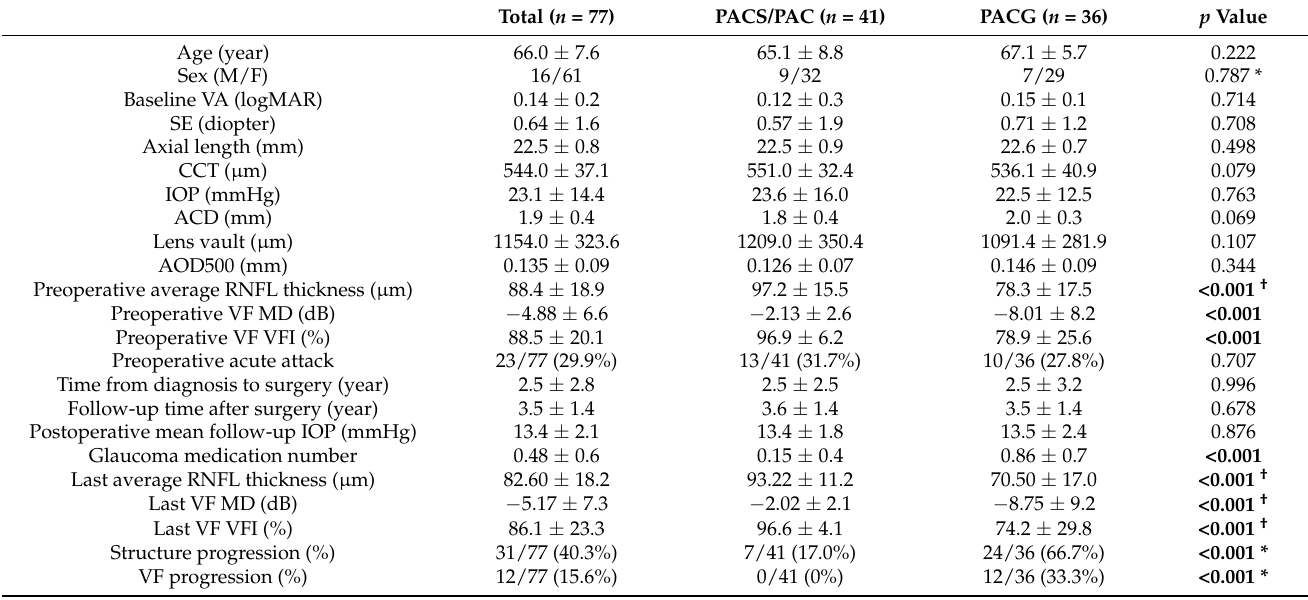
Table 1. Comparison of clinical and demographic characteristics of eyes with primary angle closure suspect, primary angle closure, and primary angle closure